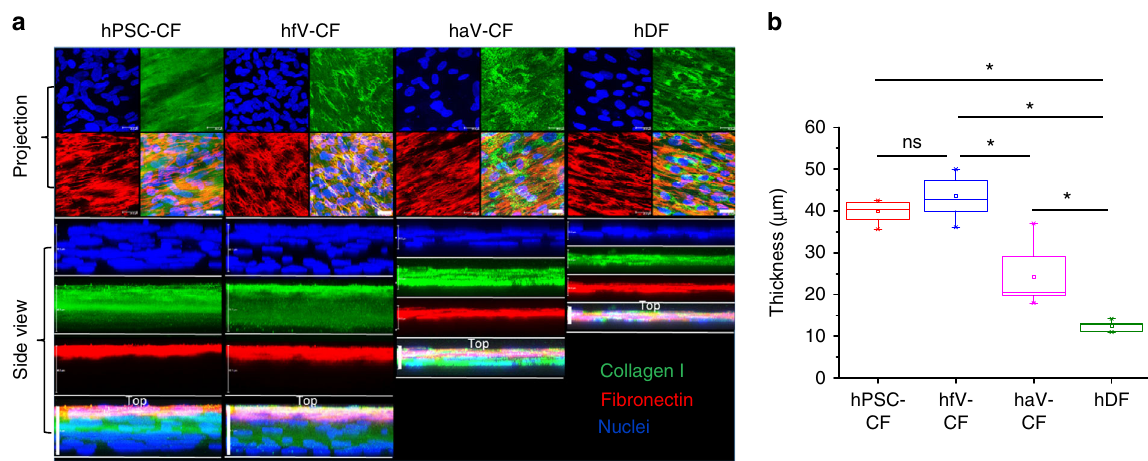
Fig. 8 ECM production in CF and DF cultures. a Confocal imaging of high density cultures of hPSC-CF, hfV-CF, haV-CF, and hDF immunolabeling for extracellular collagen I and fi bronectin. Z-scans are presented as projection images in the top panels and 3D reconstructions showing side views in lower panels. Scale bars in Projection are 25 μ m. Scale bars in Side view of hPSC-CF and hfV-CF are 40 μ m, haV-CF are 20 μ m, and hDF are 15 μ m. b Thickness of the 3D ECM scaffolds measured from 3D reconstructions of hPSC-CF ( n = 8), hfV-CF ( n = 9), haV-CF ( n = 12), and hDF ( n = 6) biological replicates. The box plots summarize the biological replicates with the box enclosing from fi rst to third quartile, middle square indicating mean, line in box indicating median, and whiskers indicating outliers. * P < 0.05, one-way ANOVA with post hoc Bonferroni